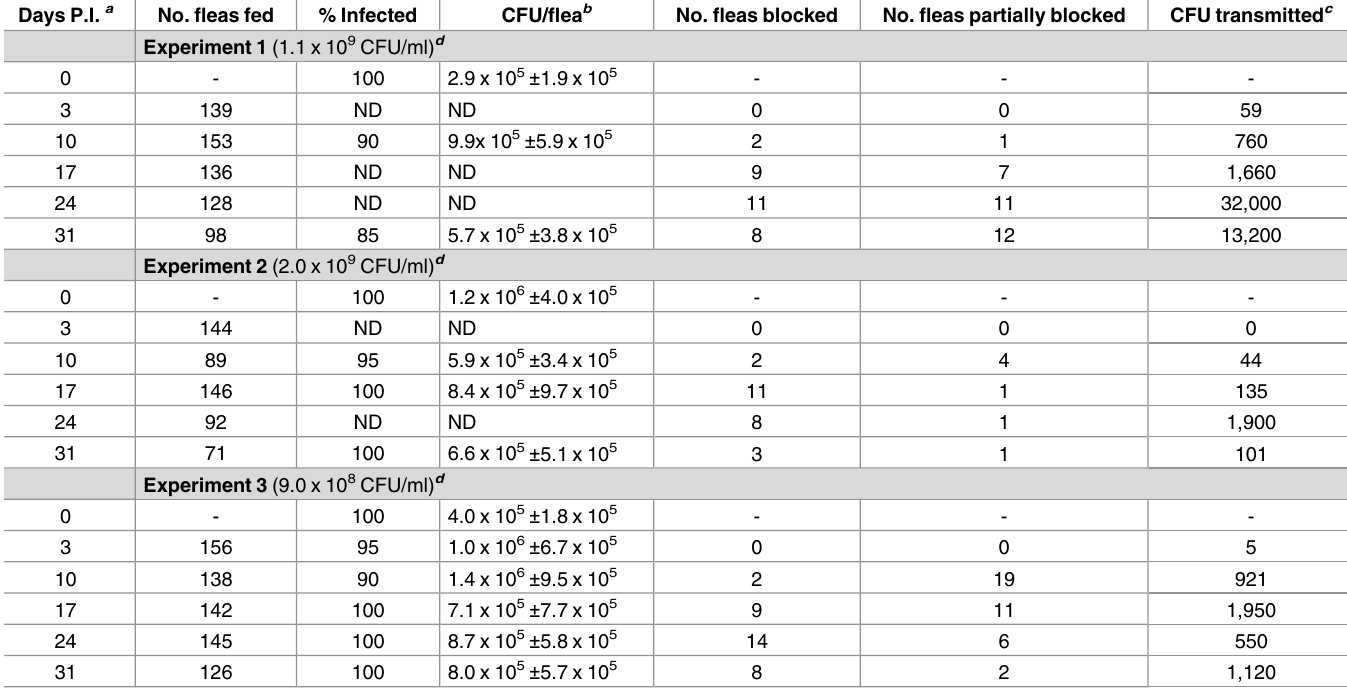
a Days after the infectious blood meal. Day 0 indicates the day of infection; data for this day are included to show the initial infectious dose (no transmission test was done). b Mean ± SD in infected fleas. c Data used for Fig 4B. d Conc. of Y . pestis in infectious blood meal on day 0. ND = not determined.